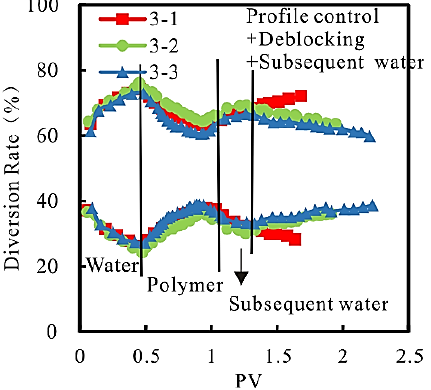
Figure 8. Relationship between diversion rate and PV.